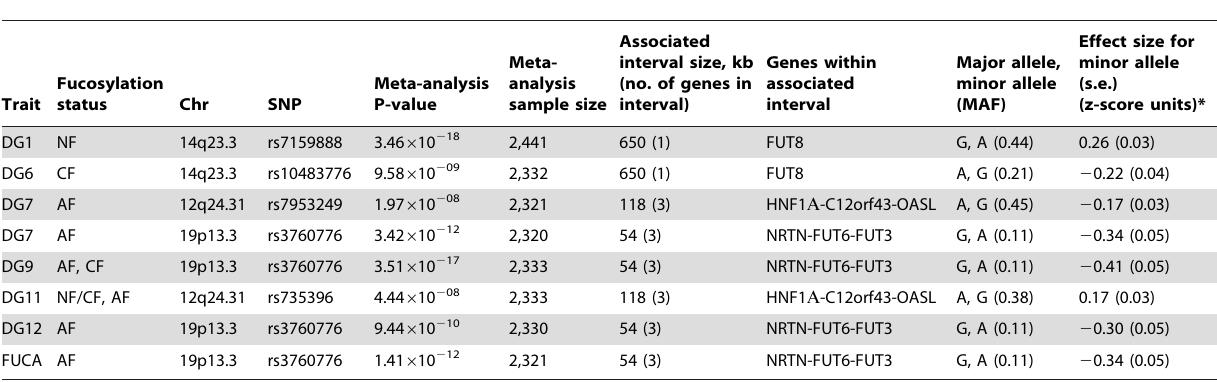
Table 1. Genetic markers associated with plasma N-glycan